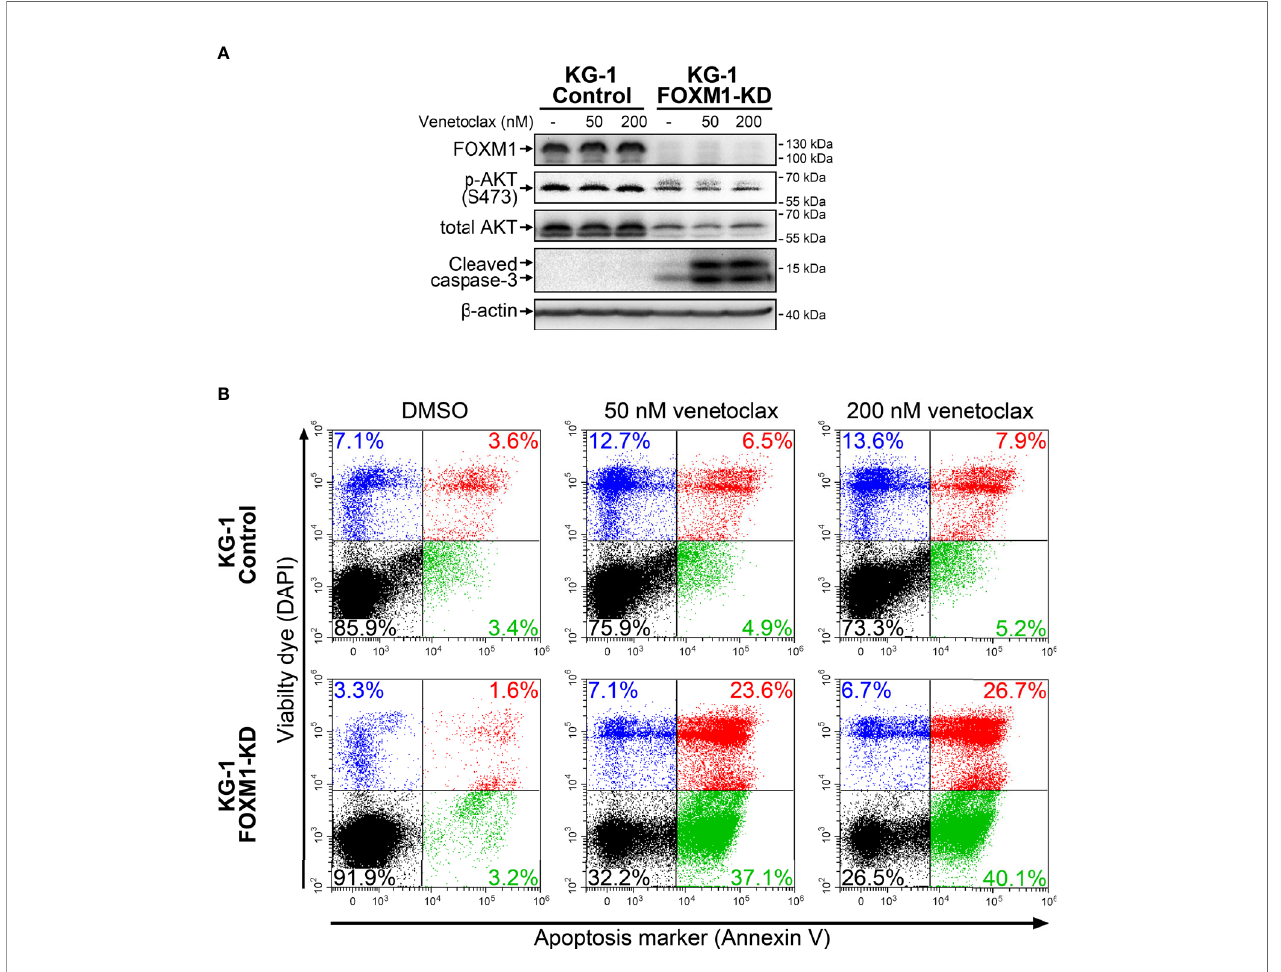
FIGURE 3 | FOXM1 knockdown in KG-1 cells increases their sensitivity to venetoclax. KG-1-Control and KG-1-FOXM1-KD cells were treated with indicated concentrations of venetoclax for 24 hours. (A) Total protein samples were puri fi ed immediately after treatment and analyzed via immunoblotting with indicated antibodies. Apoptotic activity was evaluated based on caspase-3 cleavage, b -actin was used as an internal loading control. (B) Cells were harvested immediately after treatment and stained with Annexin V and DAPI. Flow cytometry-based Annexin V assay was performed to identify viable (DAPI low /Annexin V low , black), early apoptotic (DAPI low /Annexin V high , green), early necrotic (DAPI high /Annexin V low , blue) and dead (DAPI high /Annexin V high , red)